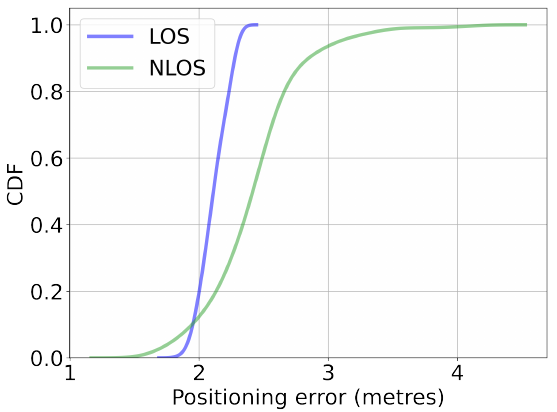
Figure 10. The CDF curves of WiFi RTT signal measure under different scenarios. A smartphone was placed 3 m away from the access point. We observed that in human NLOS experiment where the signal was blocked by human body, the minimum error of the RTT measurement increased and the maximum error grew larger as well. WiFi RTT became more unreliable under NLOS